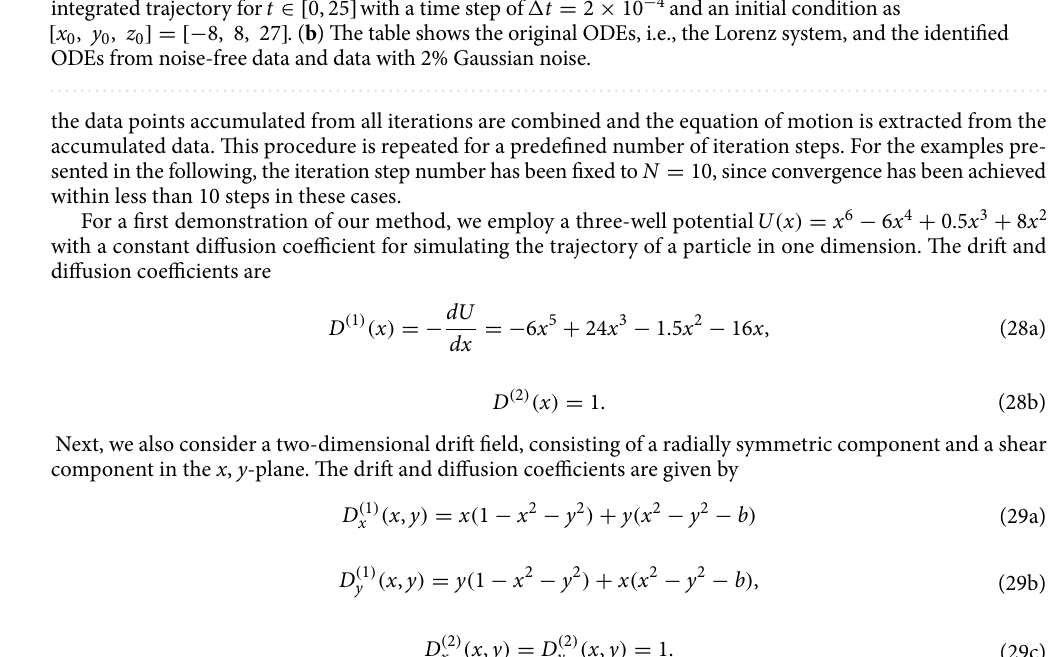
4 and an initial condition as 2 10 − = ×